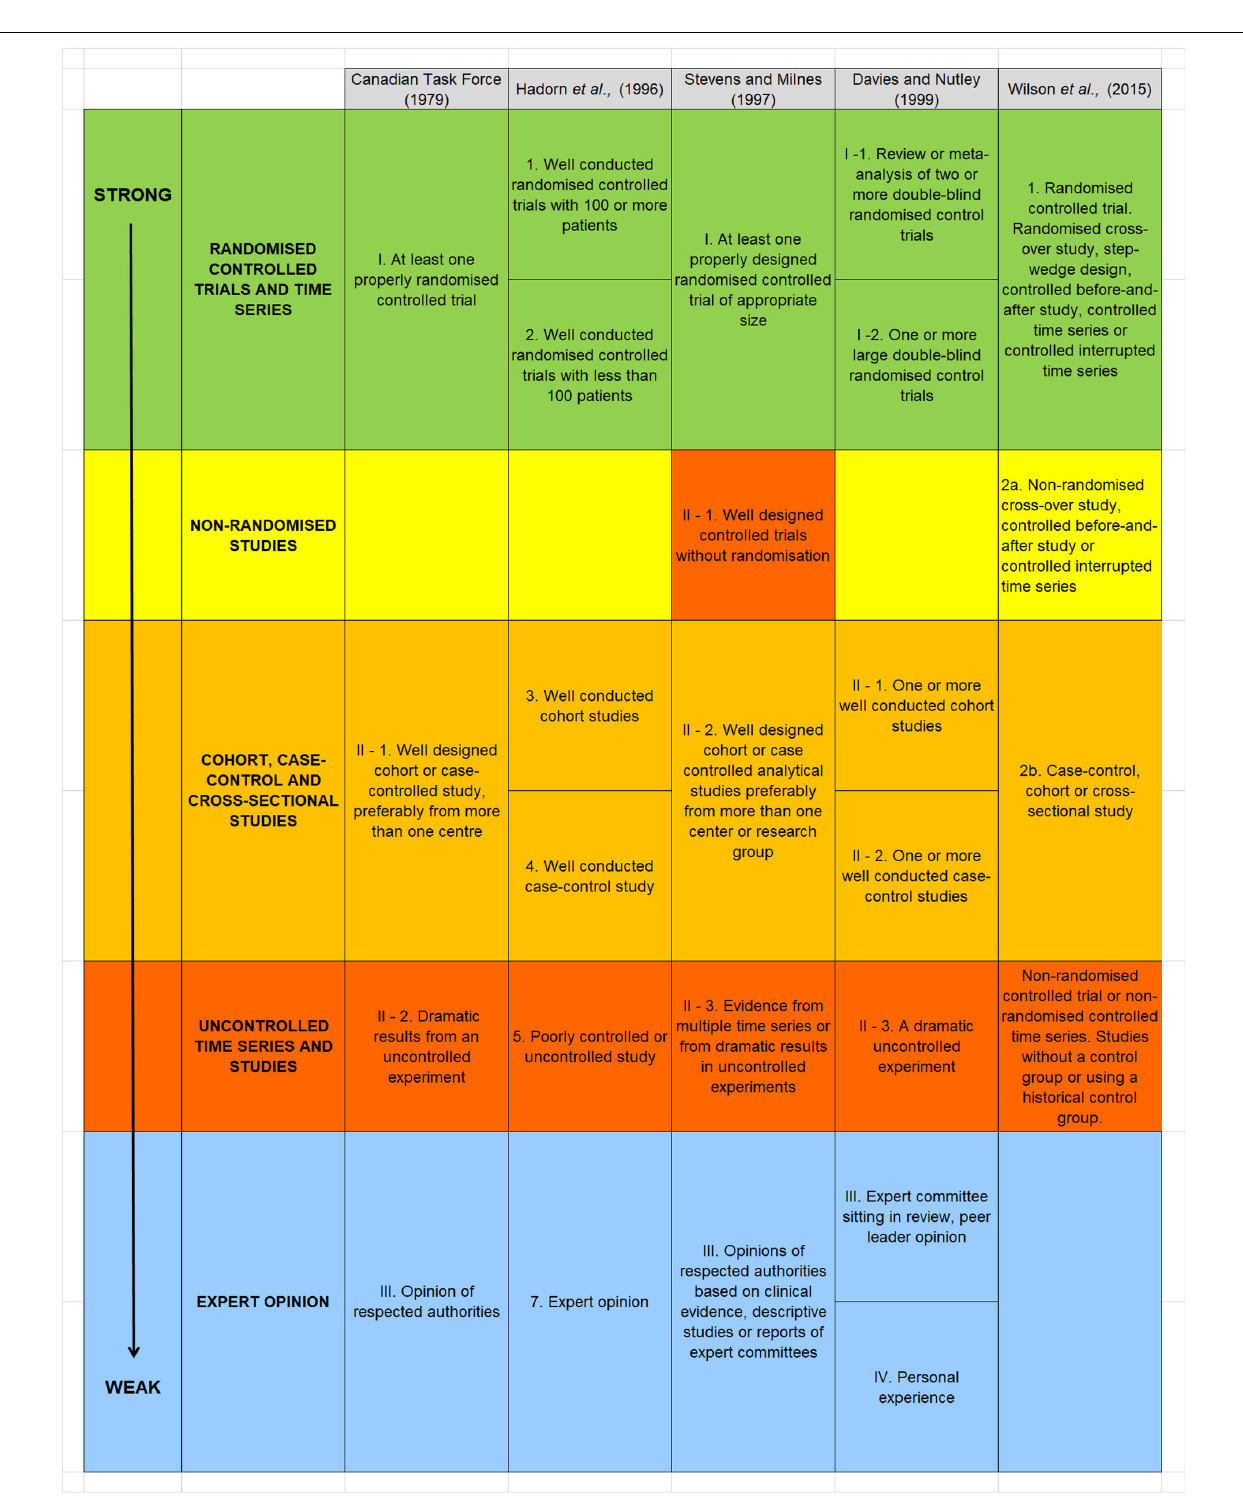
Frontiers in Marine Science |